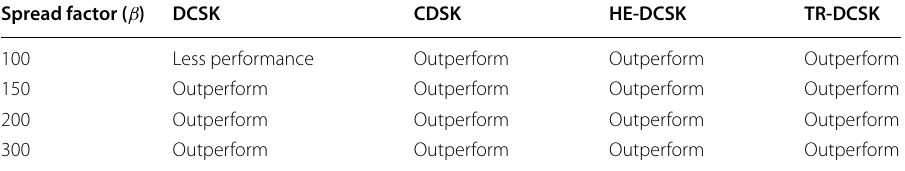
Table 4 SR‑PI‑DCSK performance comparison with different chaotic systems at different spreading